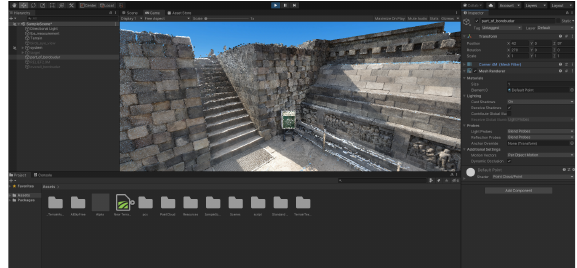
Figure 7. Switching of the viewing styles using the Unity